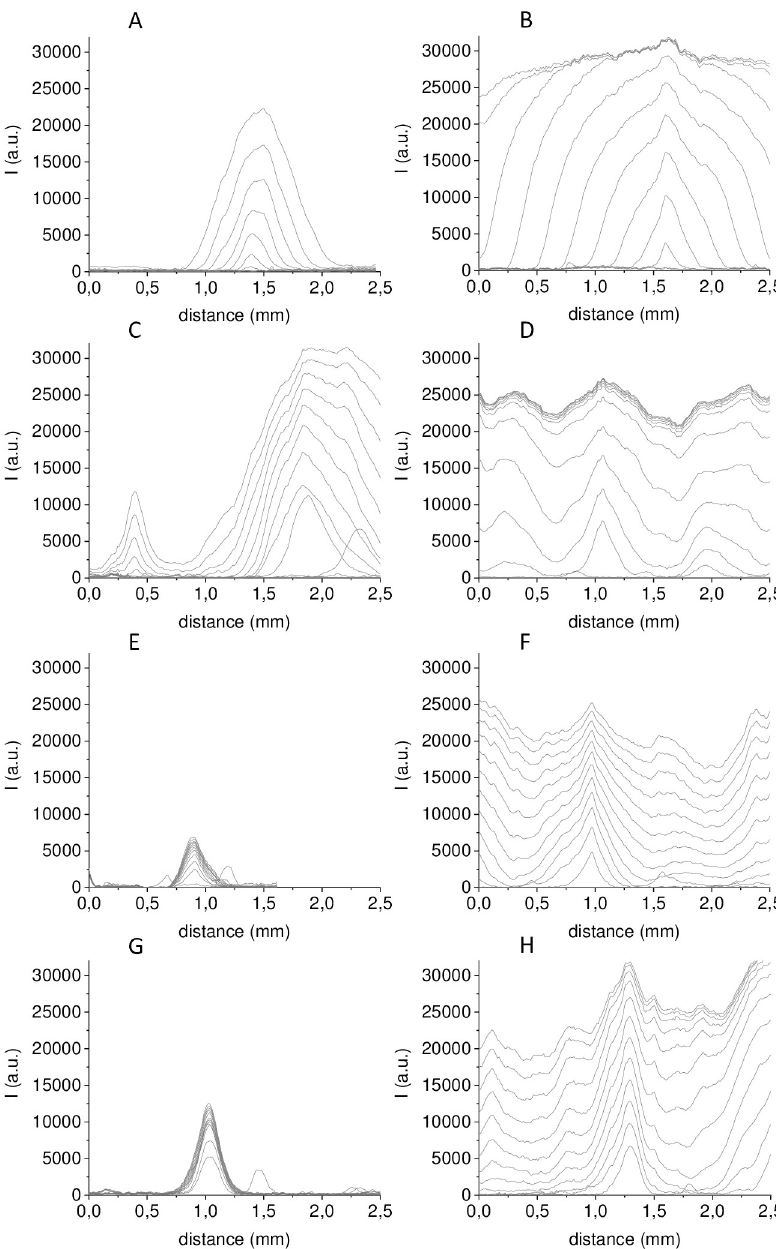
Fig 5. The light scattering intensity profiles of spontaneous clots induced by MPs of different origins. Clotting was induced in normal MP-depleted plasma by supplementation of (A) platelet MPs, (B) erythrocyte MPs, (C), (E), (G) endothelial MPs, monocyte MPs, THP MPs respectively in conditionally “low” concentrations, (D), (F), (H) endothelial MPs, monocyte MPs, THP MPs respectively in conditionally “high” concentrations. The time interval between profiles is 5